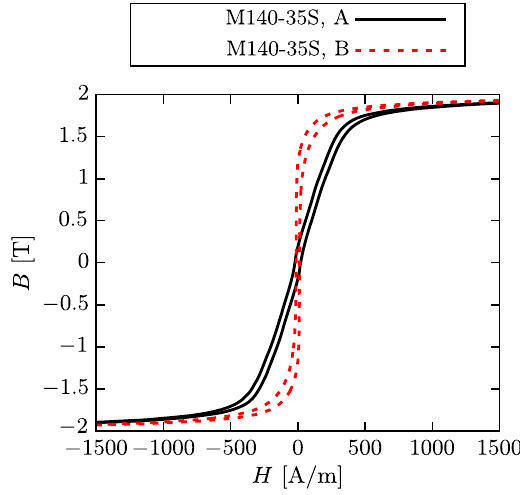
FIG. 11. Hysteresis cycle for M140-35 S from two different suppliers A and B.